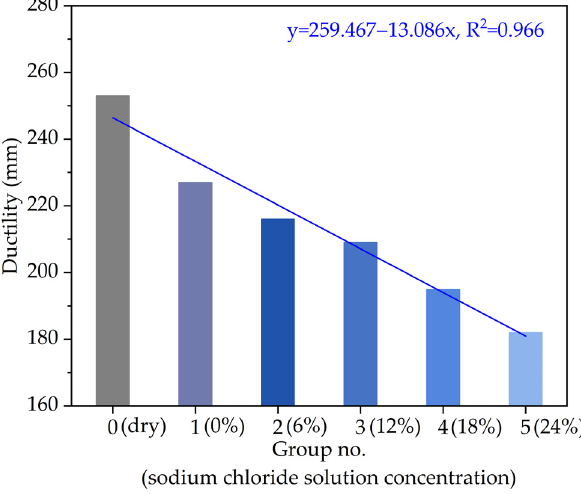
Figure 5. The variation of ductility at 10 °C with different chloride salt concentrations.